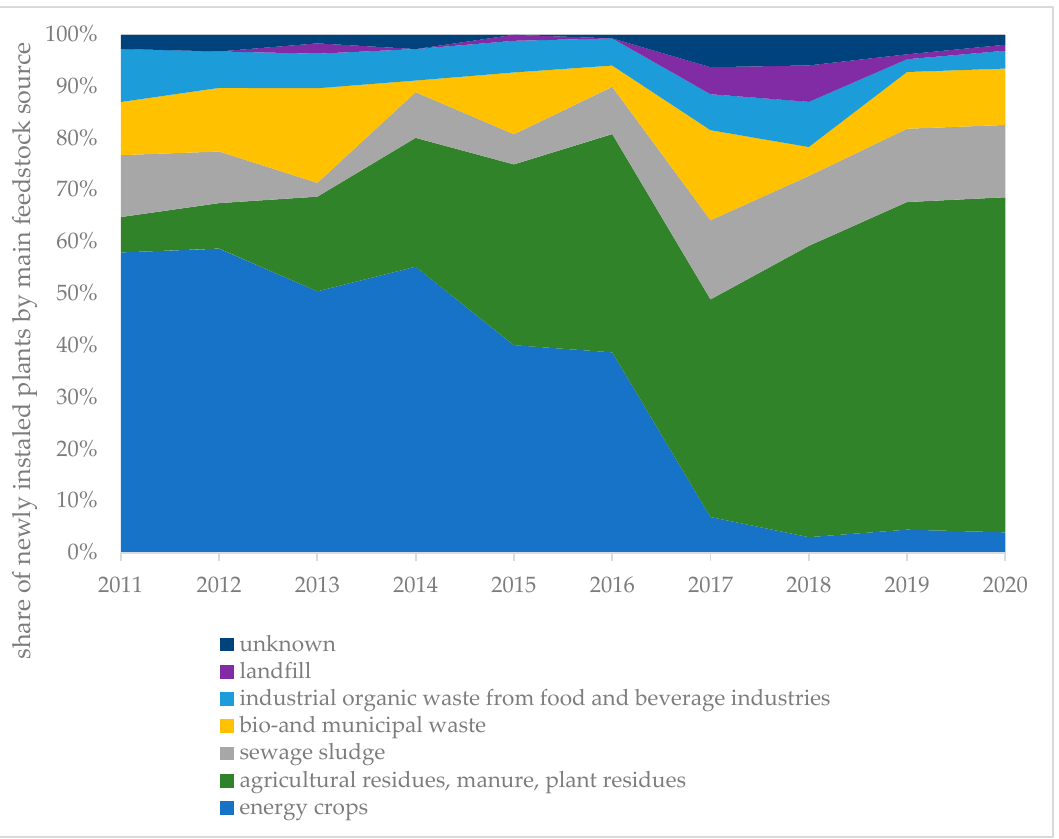
Figure 7. Changes in the structure of newly commissioned biomethane plants in the EU by the main substrate in 2011–2022. Source: own elaboration based on EBA [6].